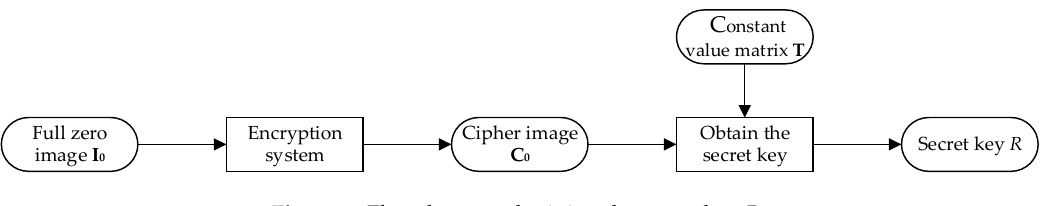
Figure 3. Flowchart on obtaining the secret key R .